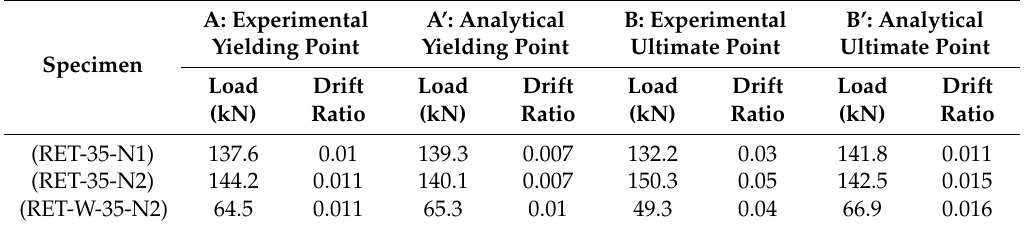
Table 9. Yielding and ultimate load-drift ratio data for the experimental and analytical results (Lam and Teng [20]).